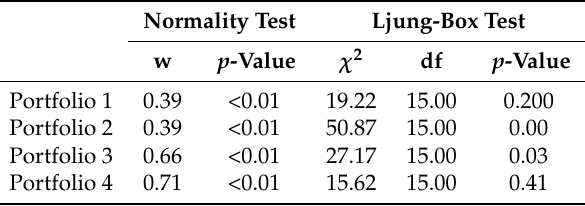
Table A2. Diagnosis of two-factor residuals